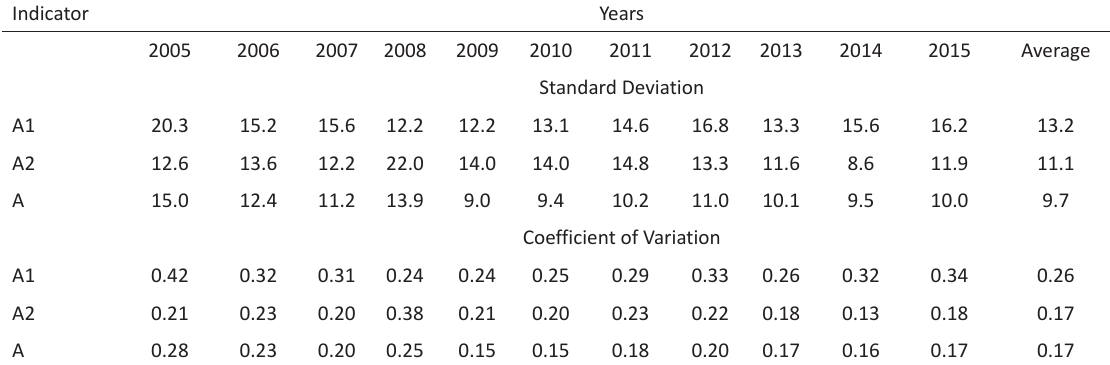
Table 5. Dispersion of strategies for working capital management of food companies from Northern Europe Indicator